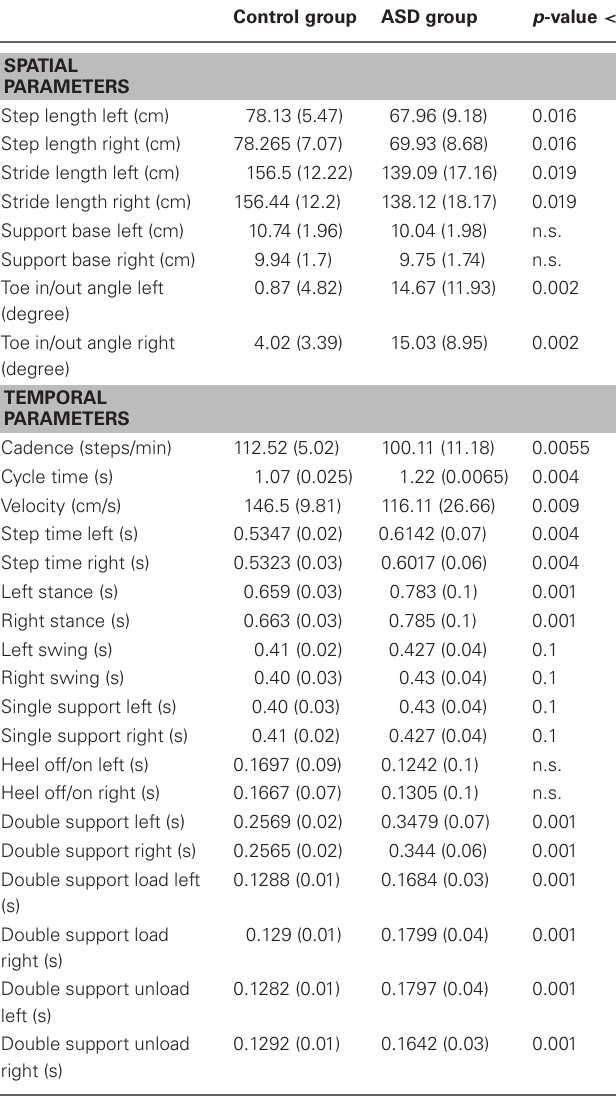
Table 3 | Summary of ASD and control participants’ means (standard deviations) and p -values compared on spatial and temporal parameters of the gait